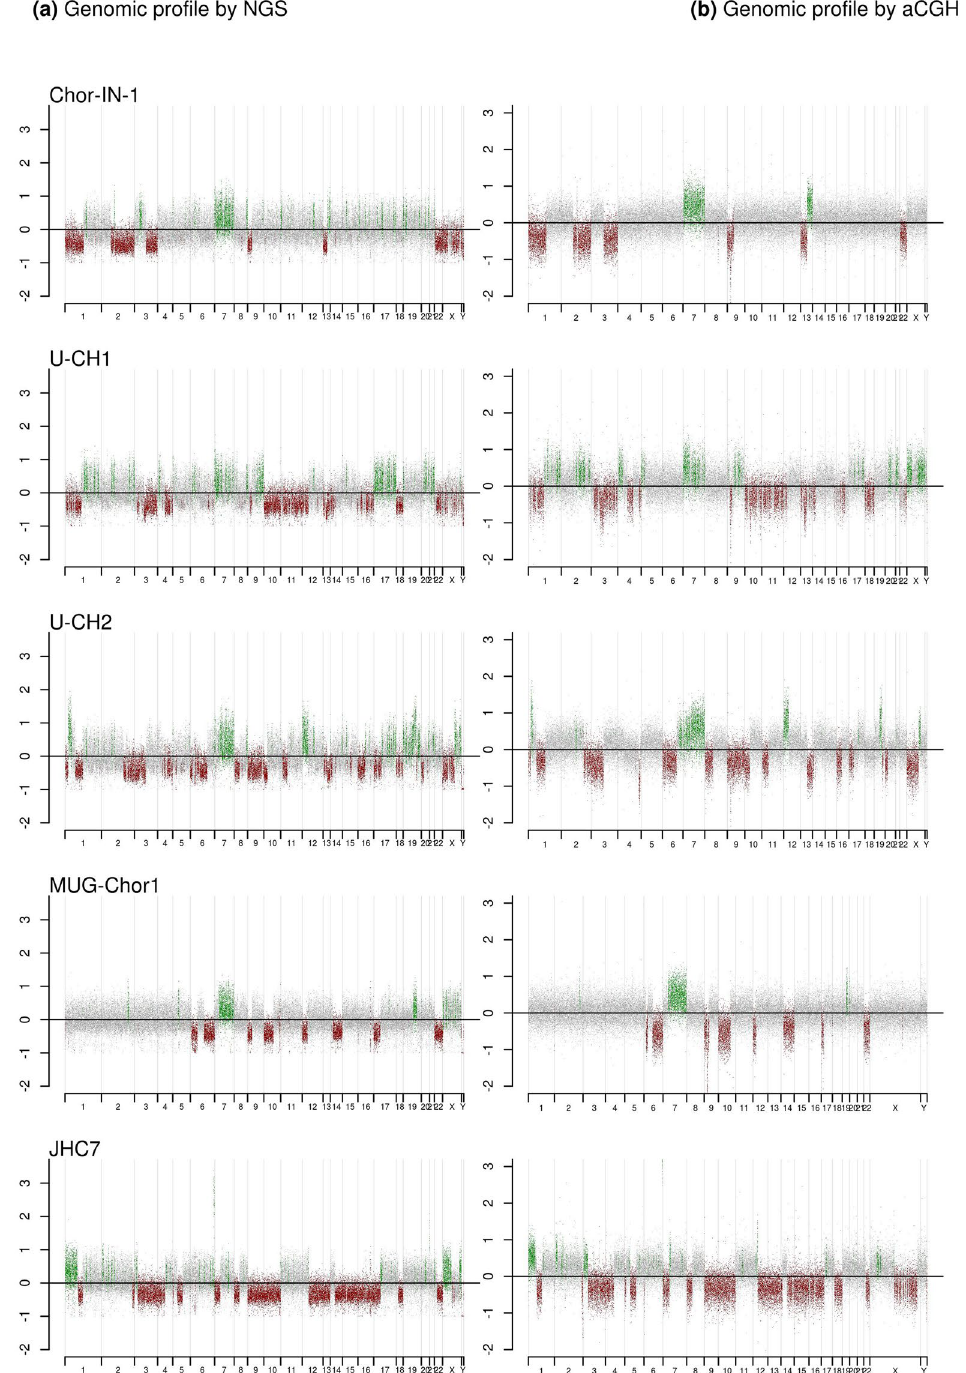
Figure 4. NGS and aCGH copy number profiles on the different chordoma cell lines.Copy number profiles of Chor-IN-1 cell line vs . the other chordoma cell lines obtained by NGS and aCGH analysis: ( a ) NGS analysis: the different cell lines were profiled by NGS using Illumina TruSight One “clinical exome” panel (Illumina, San Diego, CA, USA). Log2 ratio of the coverage calculated in each interval vs . medium coverage is reported in the plot. ( b ) aCGH analysis: the different cell lines were profiled by aCGH. The Array Comparative Genomic Hybridization (aCGH) characterization was performed using the oligonucleotide-based microarray CytoChip Cancer 8 × 60 kv2.0 for Chor-IN-1, U-CH1 and U-CH2 samples and CytoChip ISCA 8 × 60 K v2.0 for MUG- Chor1 and JHC7 samples (BlueGenome Ltd, Cambridge, UK). Log2 ratio of cell line (ch1) vs . reference (ch2) value was calculated. Regions with chromosomal gain (log2 ratio > 0.2) are reported in green, while regions of chromosomal loss (log2 ratio < − 0.2) are reported in red. Balanced genomic regions are reported in